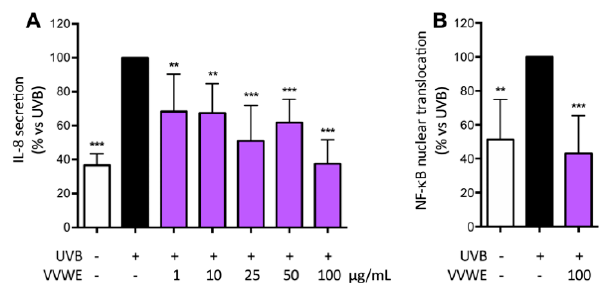
Figure 3. E ff ect of VVWE on IL-8 secretion ( A ) or NF- κ B nuclear translocation ( B ) induced by ultraviolet Figure 3. Effect of VVWE on IL ‐ 8 secretion ( A ) or NF ‐κ B nuclear translocation ( B ) induced by B (UVB) irradiation. HaCaT cells were treated for 50 s with UVB (40 mJ / cm 2 ) and followed by VVWE ultraviolet B (UVB) irradiation. HaCaT cells were treated for 50 s with UVB (40 mJ/cm 2 ) and followed for 9 h (IL-8 secretion) or 1 h (NF- κ B nuclear translocation). The graphs show the means ± SD of at by VVWE for 9 h (IL ‐ 8 secretion) or 1 h (NF ‐κ B nuclear translocation). The graphs show the means ± least three experiments performed in triplicate and duplicate, for IL-8 secretion and translocation, SD of at least three experiments performed in triplicate and duplicate, for IL ‐ 8 secretion and respectively. Statistical analysis: one-way ANOVA, followed by Bonferroni’s post hoc test. ** p < 0.01, translocation, respectively. Statistical analysis: one ‐ way ANOVA, followed by Bonferroni’s post hoc *** p < 0.001 vs. UVB alone. Here, 20 µ M EGCG were used as the reference inhibitor for UVB-induced test. * p < 0.05, ** p < 0.01, *** p < 0.001 vs. UVB alone. Here, 20 μ M EGCG were used as the reference IL-8 secretion (61.7% inhibition) and NF- κ B nuclear translocation (39.1% inhibitor for UVB ‐ induced IL ‐ 8 secretion (61.7% inhibition) and NF ‐κ B nuclear translocation (39.1% inhibition).